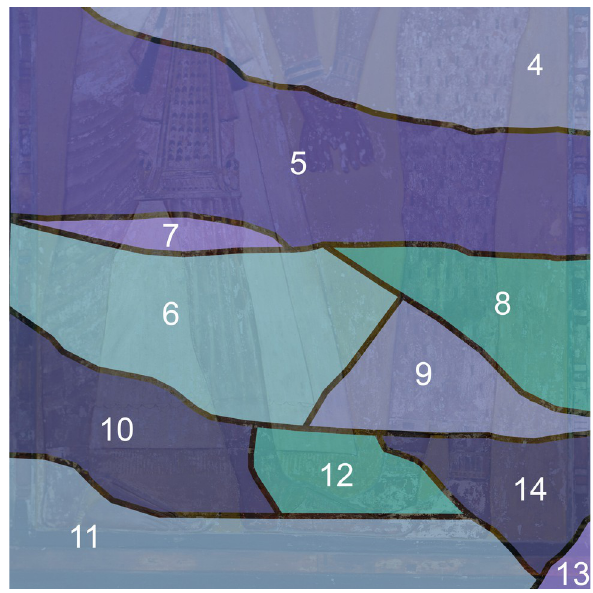
Figure 7. Mapping of the macroscopic cracks and hypothesis of the main fragments composition of the lower